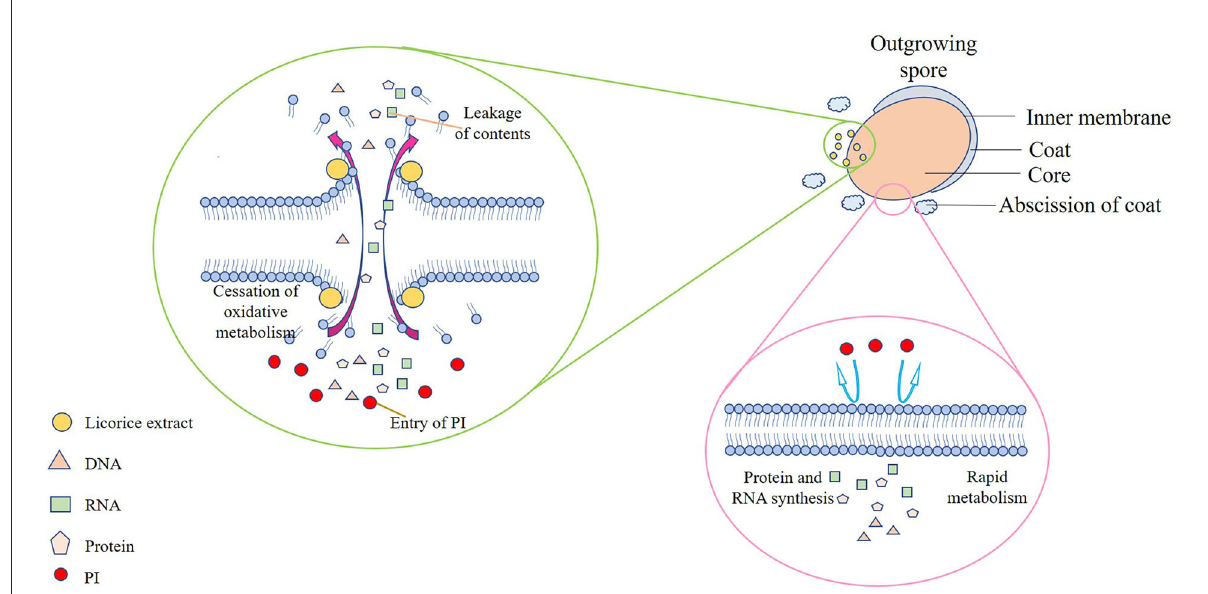
FIGURE5 Schematic model of the P. bifermentans spore outgrowth inhibited by licorice extract. The spore inner membranes are more accessible for licorice extract due to the hydrolysis of the cortex and the abscission of the coat, causing the leakage of contents, the cessation of oxidative metabolism, and the entry of PI. On the contrary, no PI can enter the complete membranes, and metabolism and synthesis proceeded normally when licorice extract is